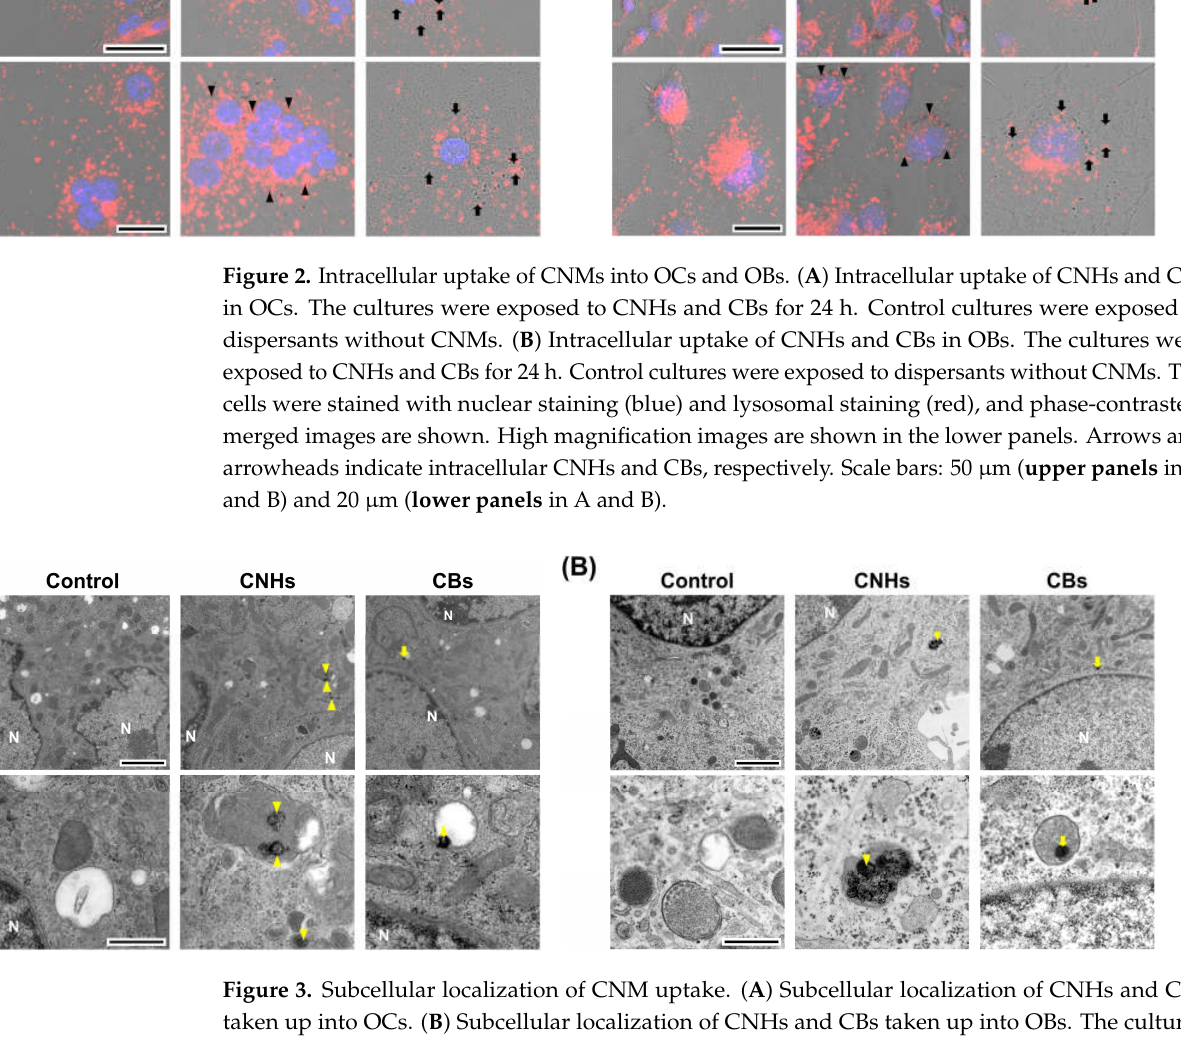
Figure 3. Subcellular localization of CNM uptake. ( A ) Subcellular localization of CNHs and CBs taken up into OCs. ( B ) Subcellular localization of CNHs and CBs taken up into OBs. The cultures were exposed to CNHs and CBs for 24 h. N, nuclei. Arrows and arrowheads indicate intracellular CNHs and CBs, respectively. High magnification images are shown in the lower panels. Scale bars: 2 µm ( upper panels in A and B) and 500 nm ( lower panels in A and B).